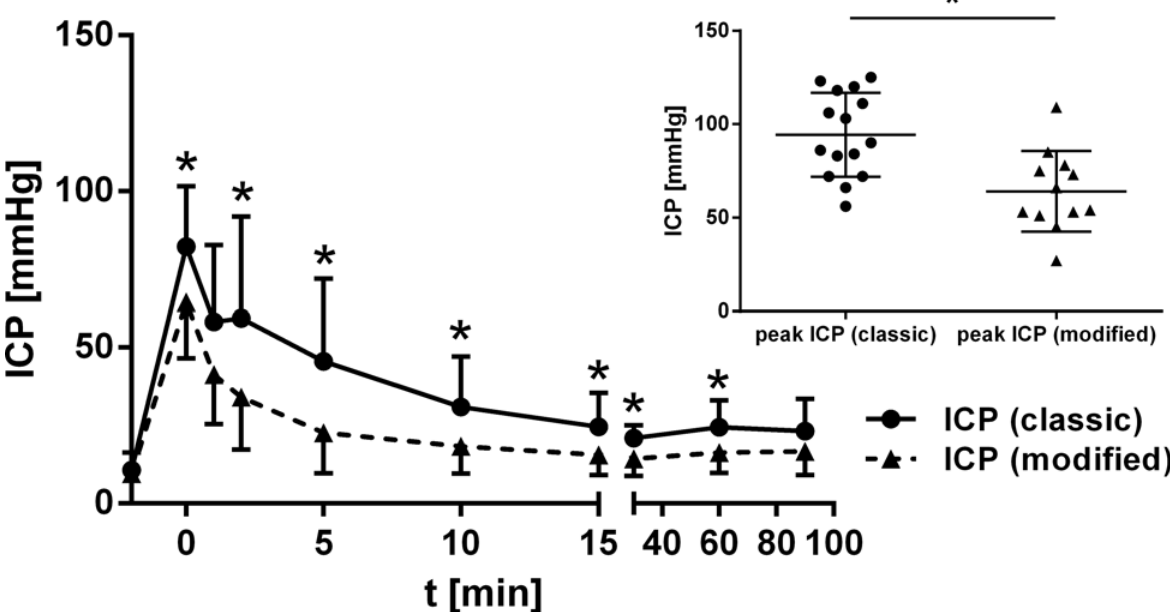
Fig 2. Chart for course of ICP. Course of ICP (mean +/- standard deviation) dependent on technique, * p < 0.05, Boxplot of peak ICP ( * p < 0.05).